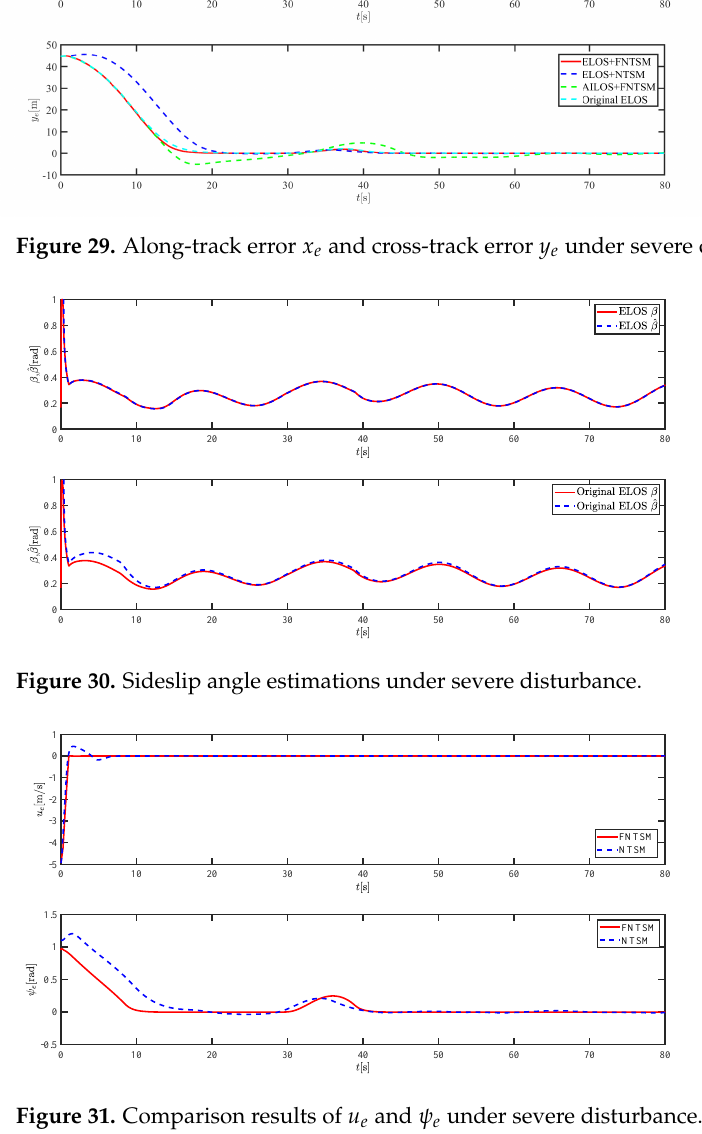
Figure 31. Comparison results of u e and ψ e under severe